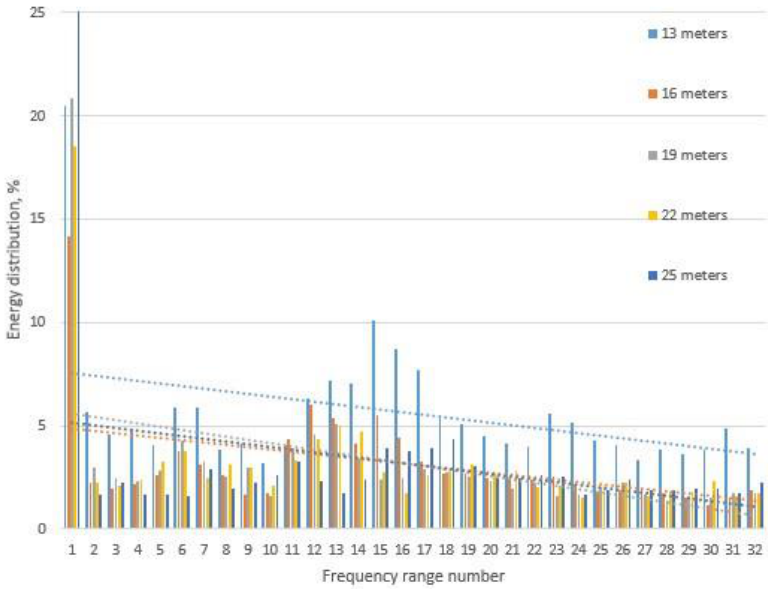
Figure 7. The signal wavelet analysis.